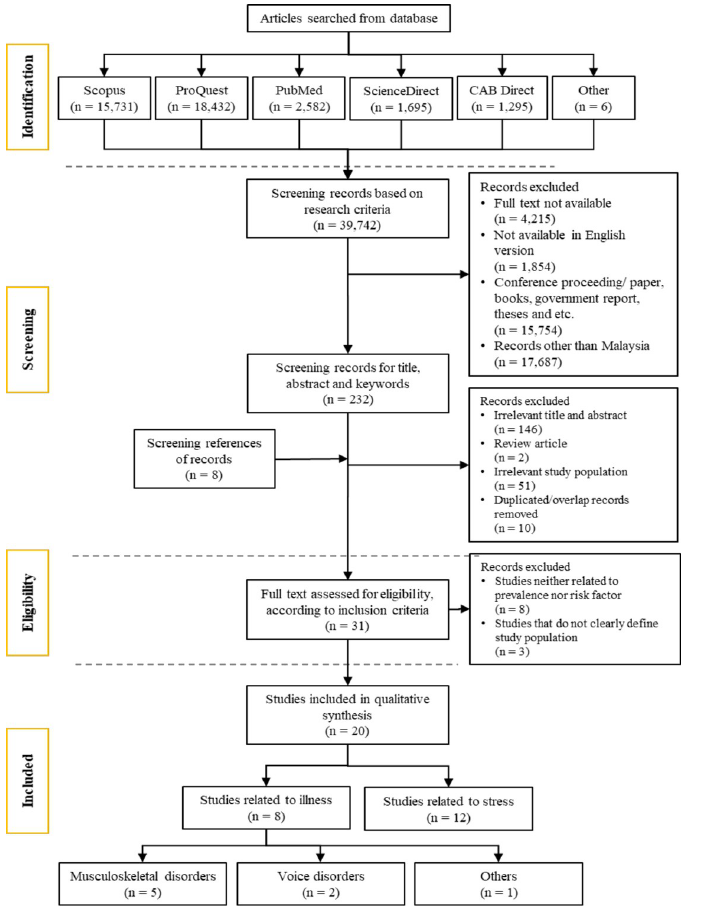
Fig 2. Flowchart of the review process.